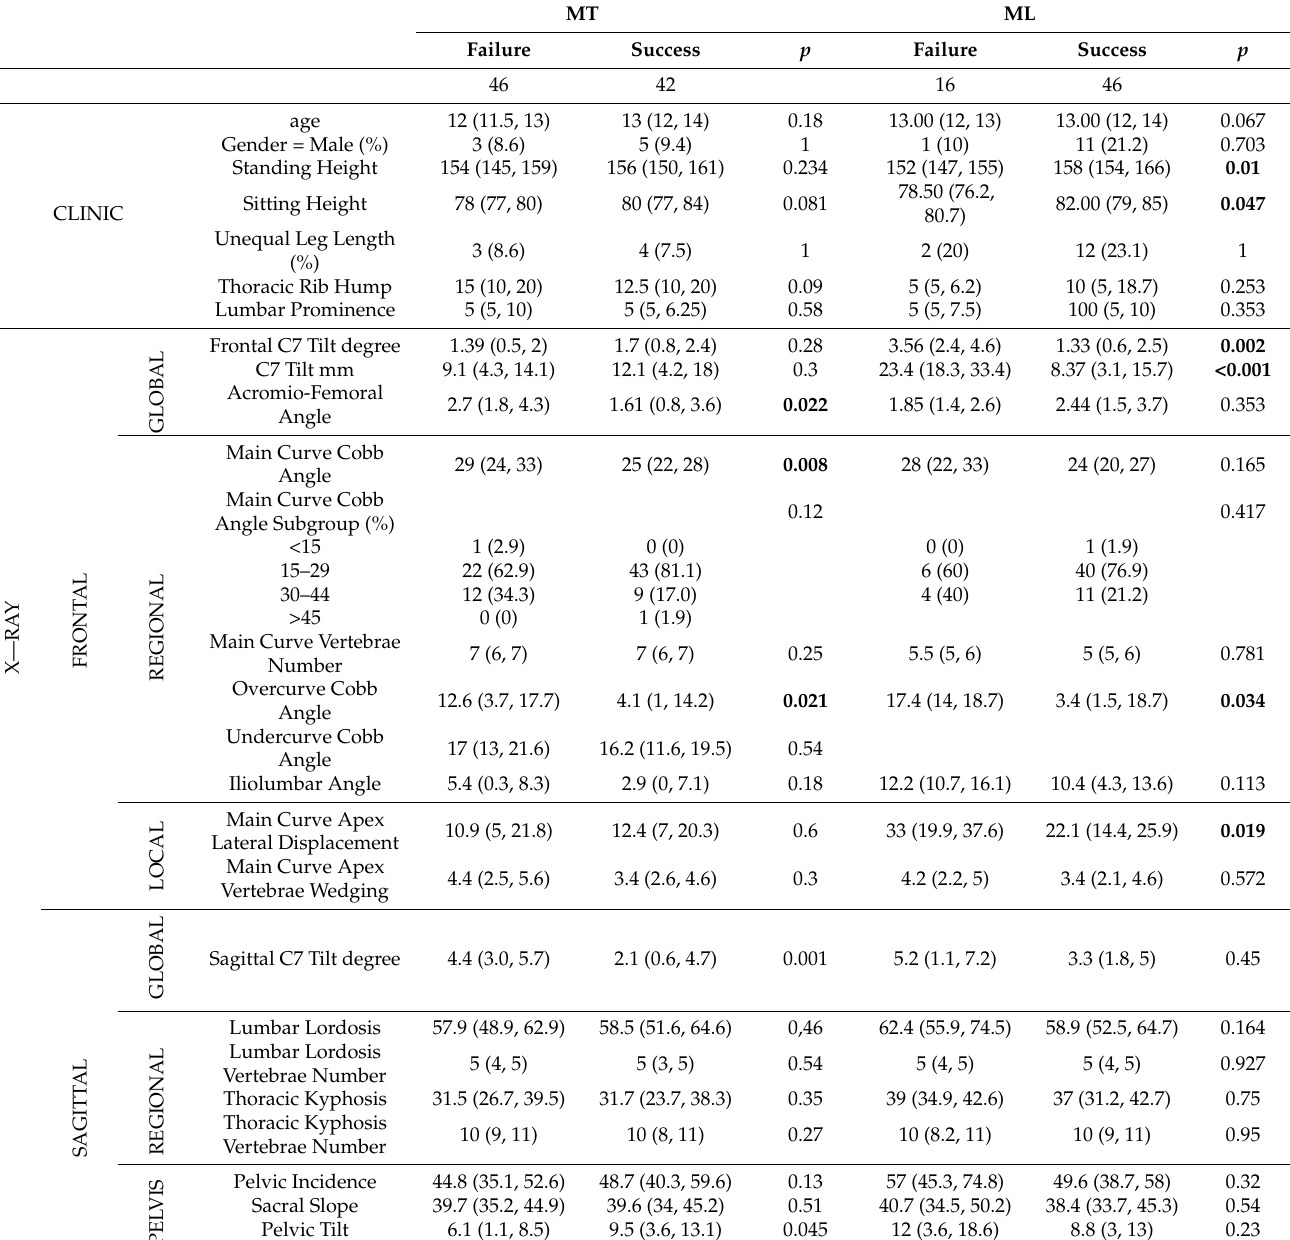
Table 4. Clinical and EOS roentgenrogram measures on date 1 (median (IQR)). Bold indicates p < 0.05